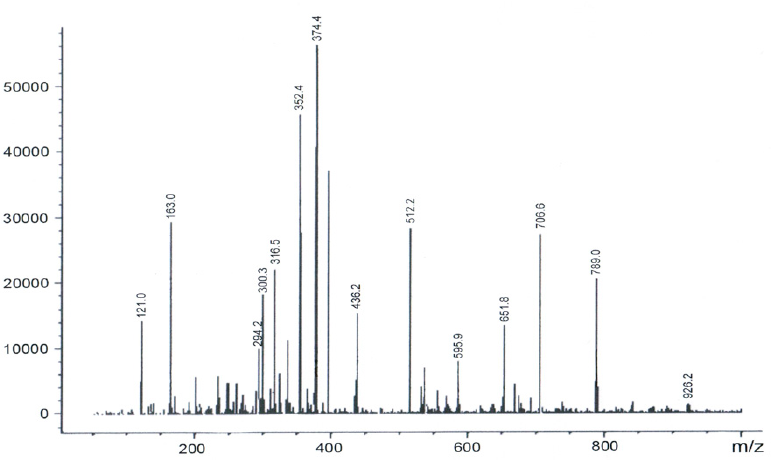
Figure 1. Electrospray ionization (ESI) mass spectrum for complex 1 .